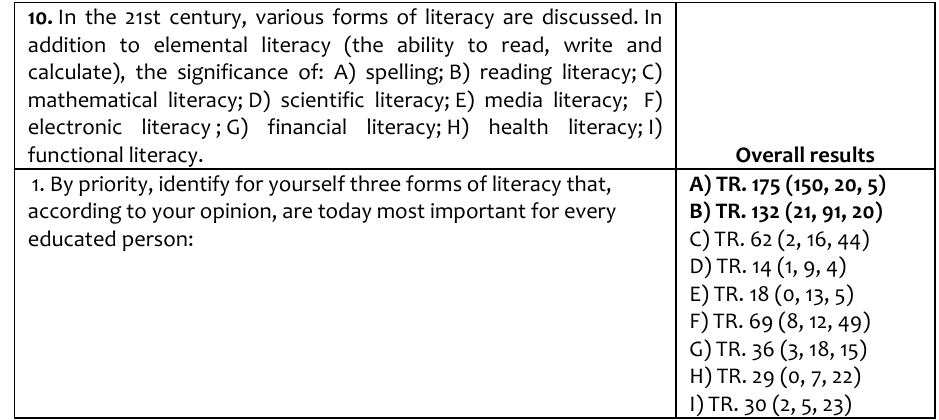
Table 11. With the carefully presented answers to question no. 10: Priorities among different forms of